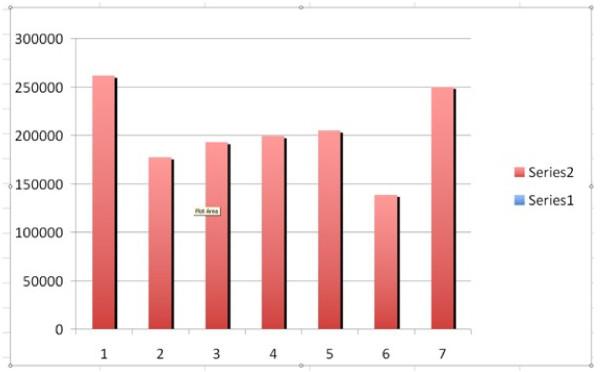
Cloning of SV40 region from GL4.13 into Nhe1 & Hind III site of GL4.82 produces SV40-RLuc.